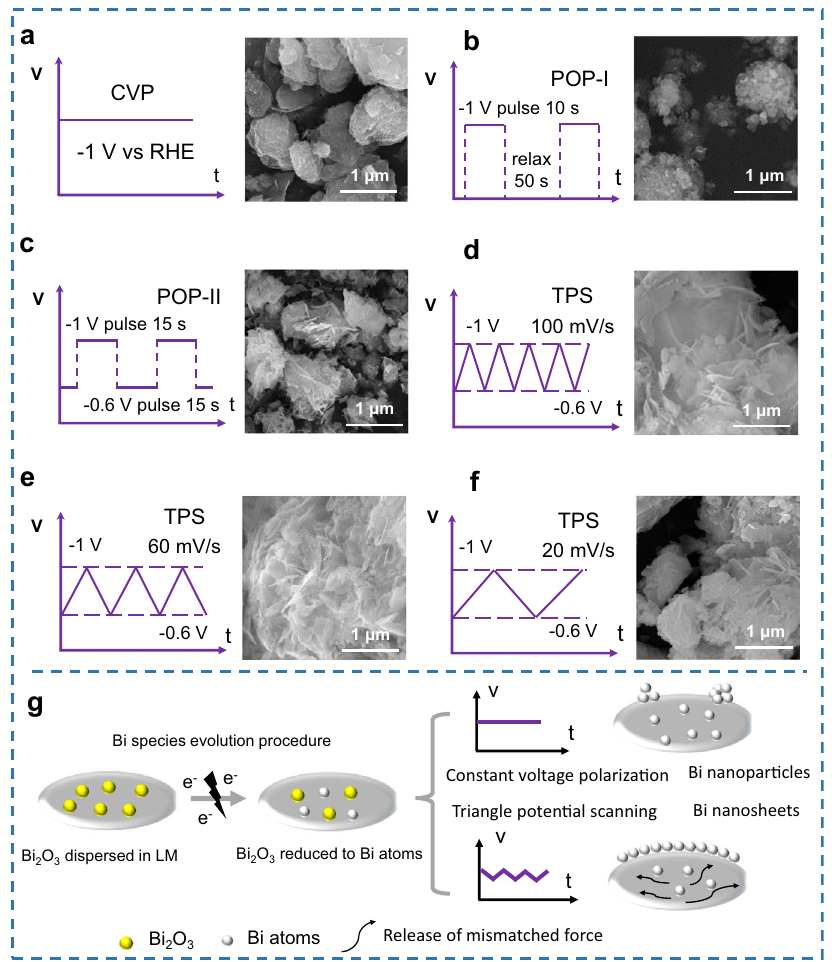
Fig. 3 | Morphology controlling of generated Bi by different electrochemical modes with corresponding images and mechanism discussion. a Constant potential polarization (constant − 1V potential applied, CVP). b Pulsing oscil- lation polarization I (pulsing 10s at − 1 V then relaxing 50s, total time keeps 1min for a cycle, POP-I). c Pulsing oscillation polarization II (the potential was